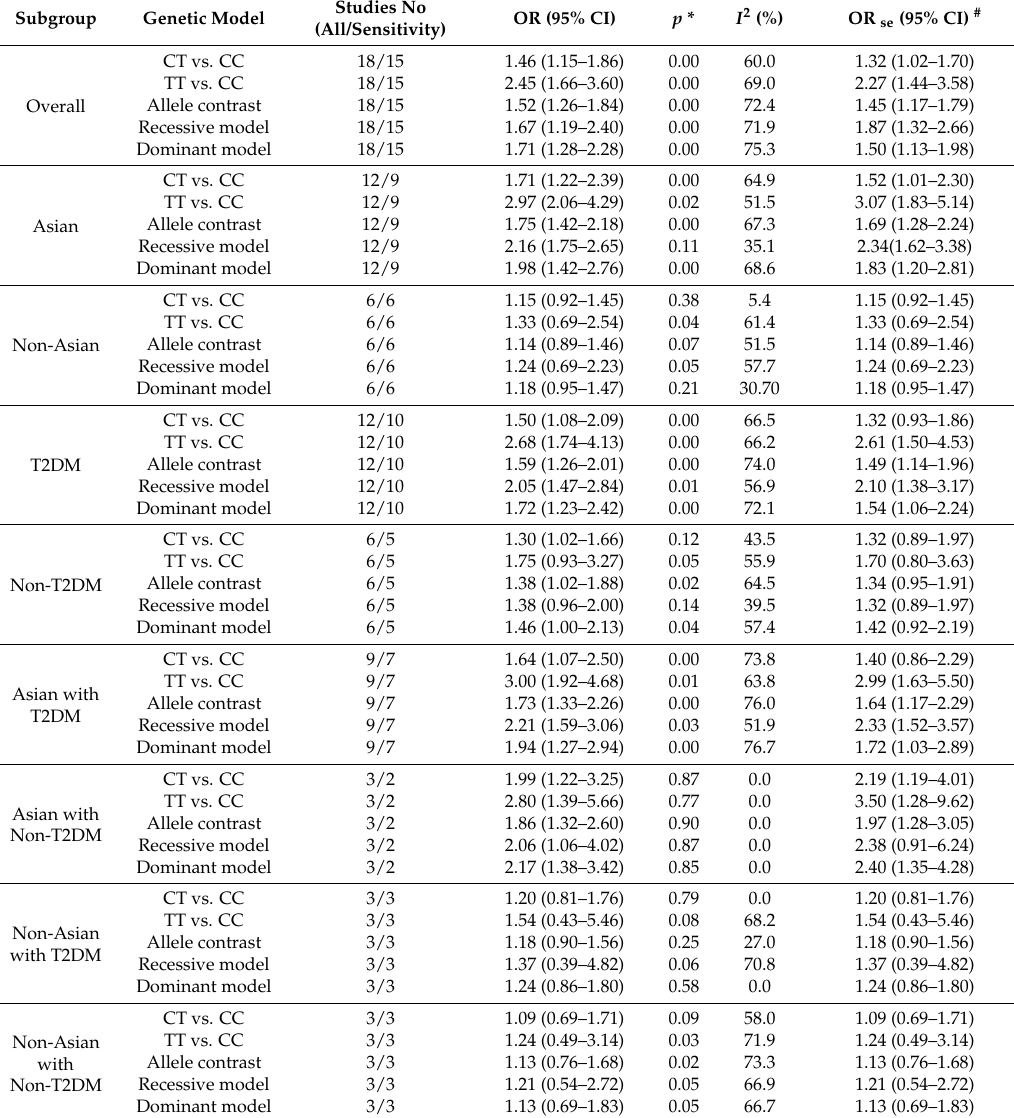
Table 3. Summary ORs and heterogeneity results for associations between the MTHFR C677T polymorphism and